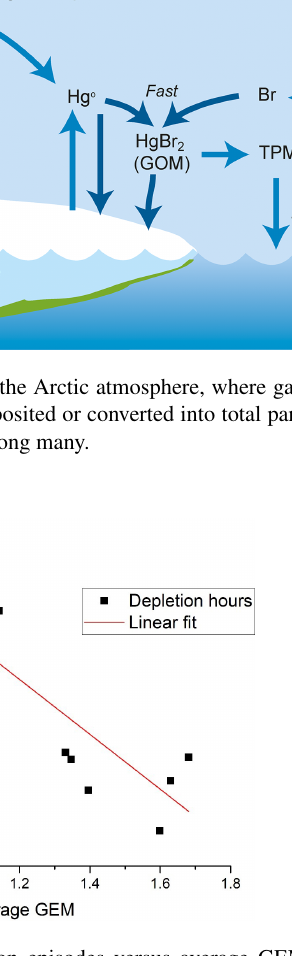
Figure 7. Frequency of depletion episodes versus average GEM concentration in March, April and May (MAM). Unit: ngm − 3